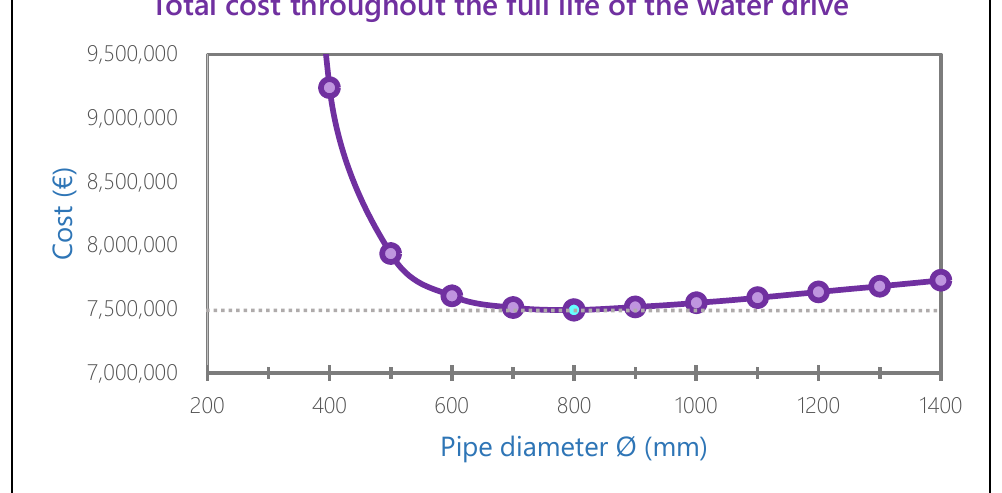
Figure 9 . Total accumulated cost of the water drive throughout the entire lifespan of the installation depending on the pipe diameter. Dimeter ∅ 800 provides the smallest total cost for the construction and operation altogether, and therefore it is the one selected, as the method previously anticipated.